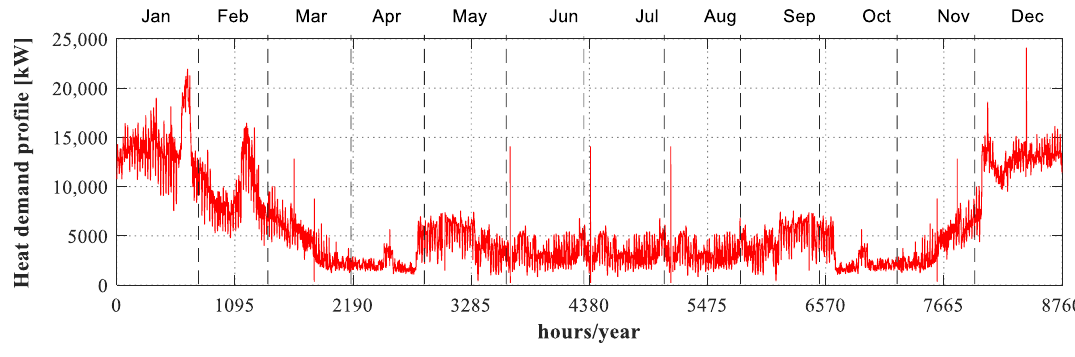
Figure 1. Schematic of the cogeneration power plant.